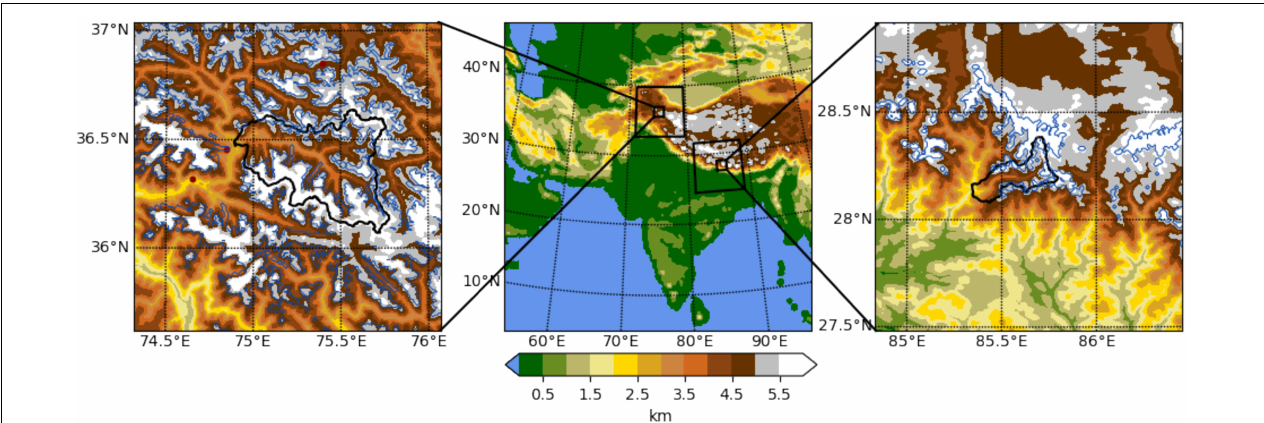
FIGURE 1 | The outer domain (D1, 25 km, middle panel), with its nests. Left panel shows the 1 km domain of Shimshal catchment (D3), and right panel 1 km domain of Langtang catchment (D5). The catchment outlines are indicated by black contours and glacier outlines of GLDAS dataset (Rodell et al., 2004) by blue contours.